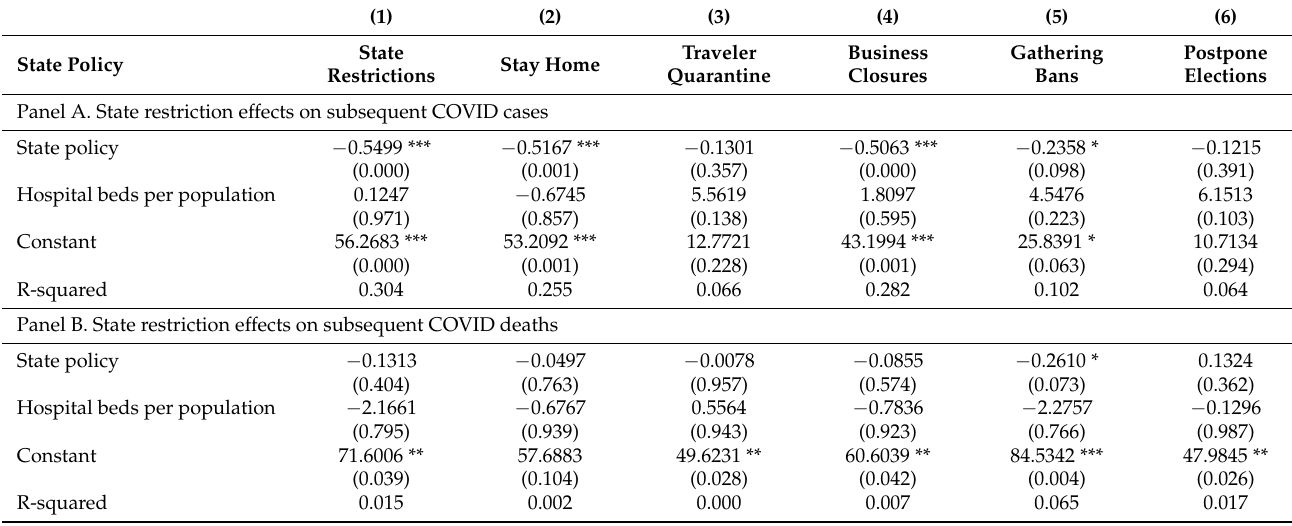
Table 4. State policy effects on local health